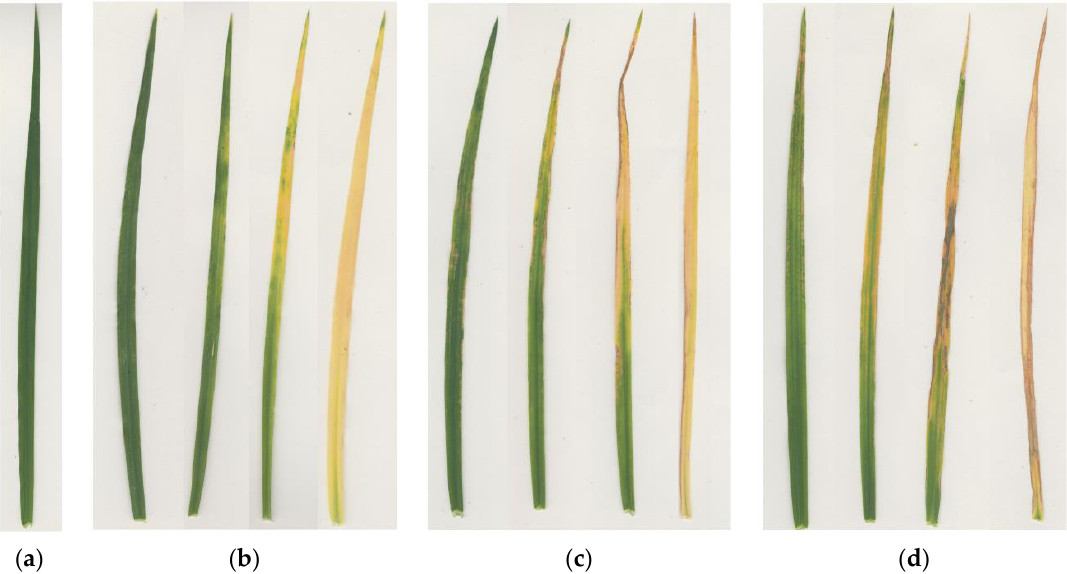
Figure A1. Untreated third leaf of Thatcher at charcoal filtered air ( a ) and third leaves selected from eight rust near-universal susceptible genotypes (Chinese Spring, Line E, Little Club, LMPG 6, McNair 701, Morocco, Rusty, and Thatcher,) showing different levels and types of O 3 injury at three O 3 treatments: 50 ppb ( b ); 70 ppb ( c ); 90 ppb ( d ), exposed for 14 days (12 h/day), at 25 °C and 50% RH, in OPECs.